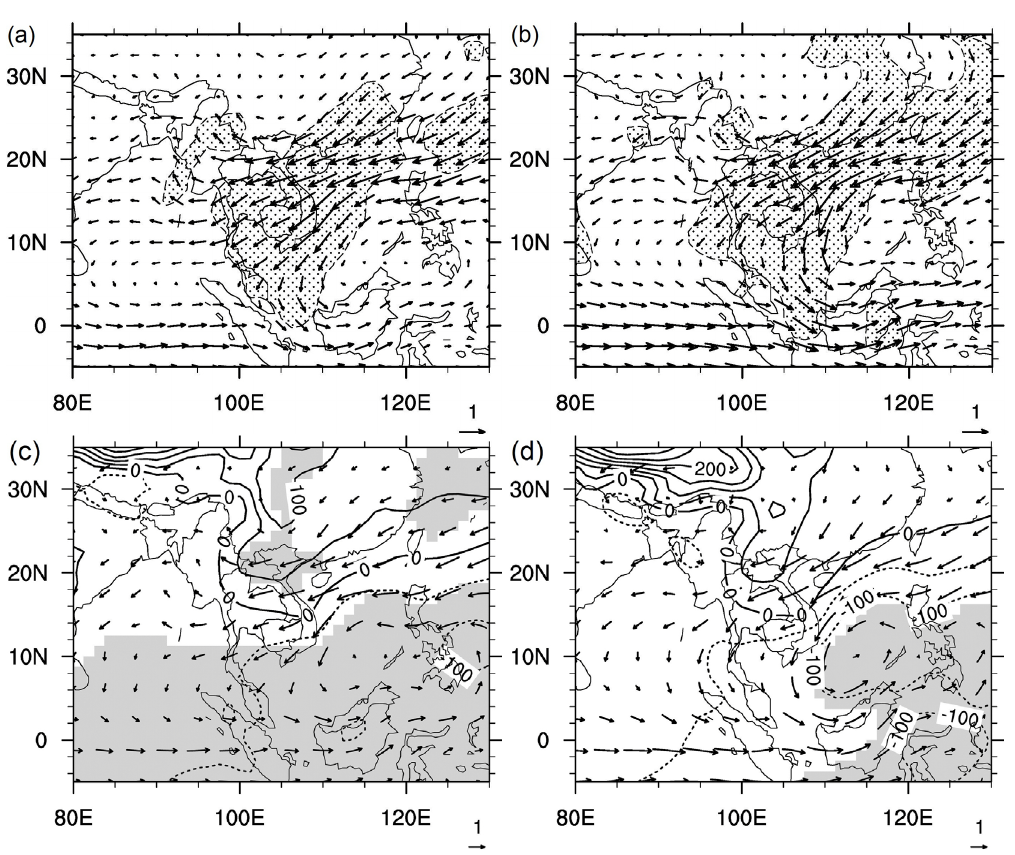
Figure 2. Regression maps of winter (DJF) 850 hPa wind components on ( a ) the primary component (PC1pri) and ( b ) the secondary component (PC1sec) of PC1 (units are in meters per second, and shading represents the 0.05 significance level correlated area to the meridional wind), whereas ( c ) and ( d ) are composite circulations for the strong phases of PC1pri and PC1sec (greater than 1SD) and ( e ) and ( f ) are patterns for the weak phases of PC1pri and PC1sec (less than −1SD), respectively. The contour line and shading in (c) to (f) represent composite anomalous SLP and the 0.05 significance level,